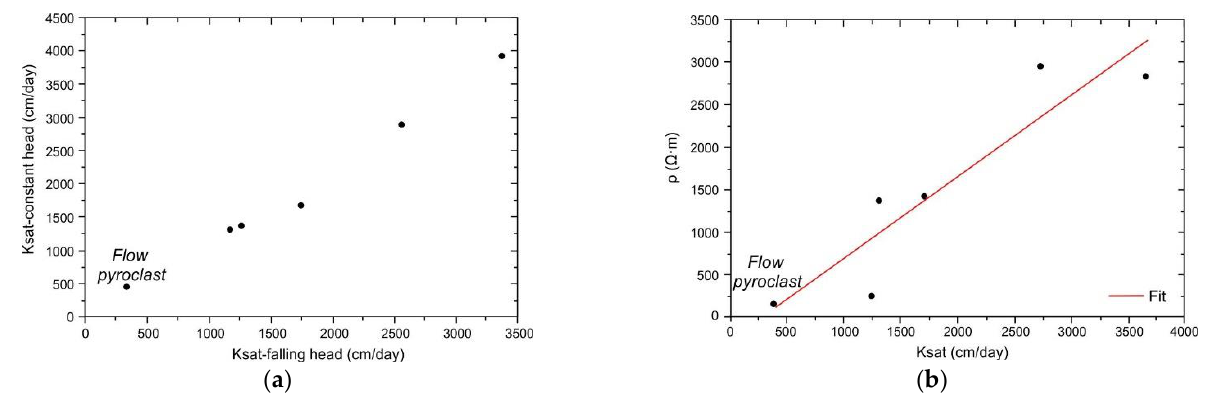
Figure 4. ( a ) Relationship between measures of hydraulic conductivity constant and variable load; ( b ) Correlation between the average values of saturated hydraulic conductivity and electrical resistivity of the Bandama’s site samples.